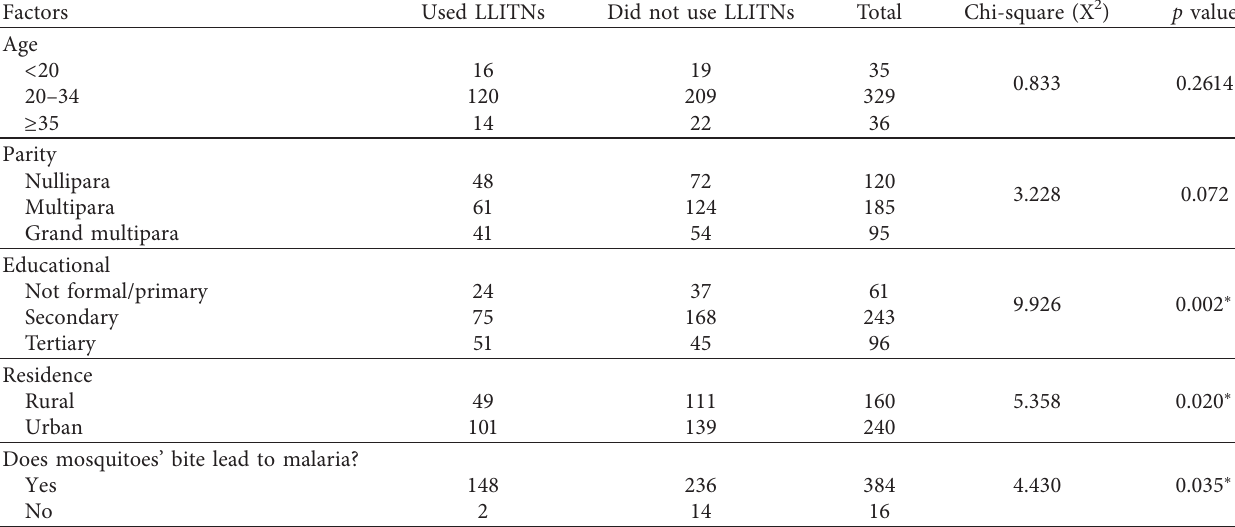
Table 4: Factors associated with the increased use of LLITNs by